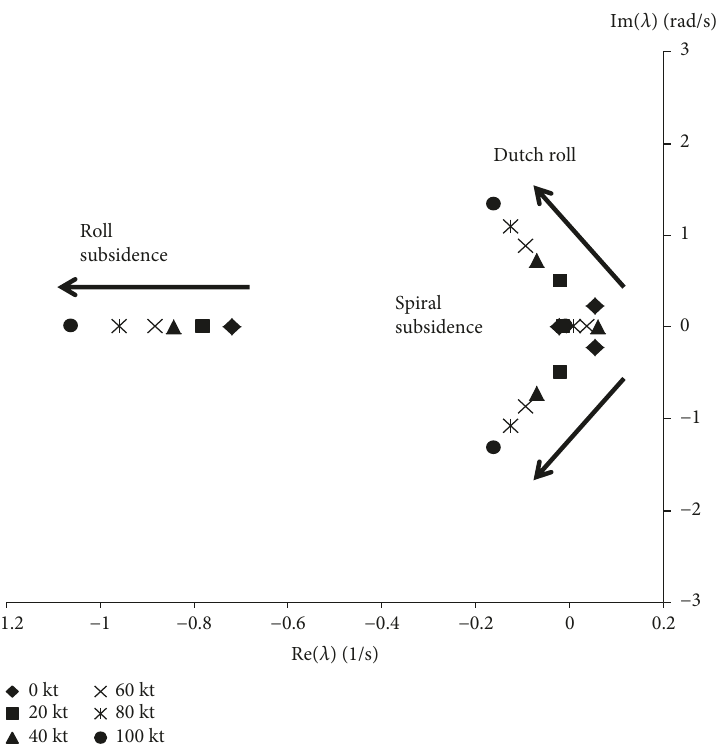
Figure 17: Lateral eigenvalue movement in helicopter mode.